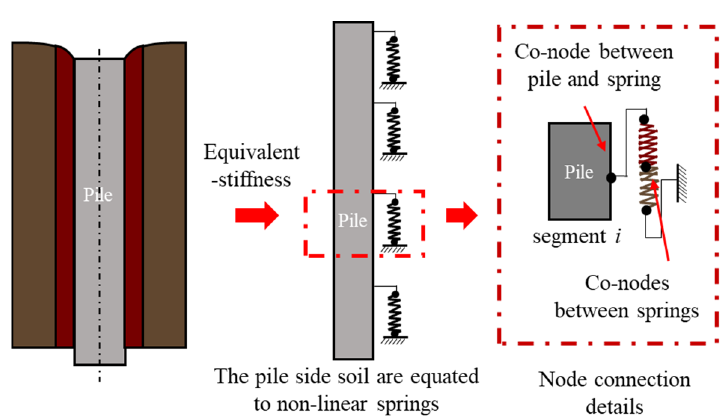
Figure 4. Calculation model of equivalent spring stiffness.